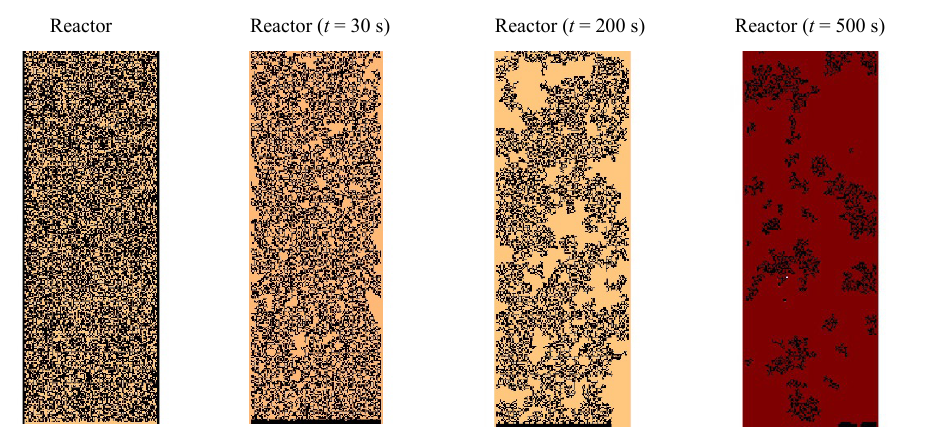
Fig. 5. Visualisation of biomass at different time frame.